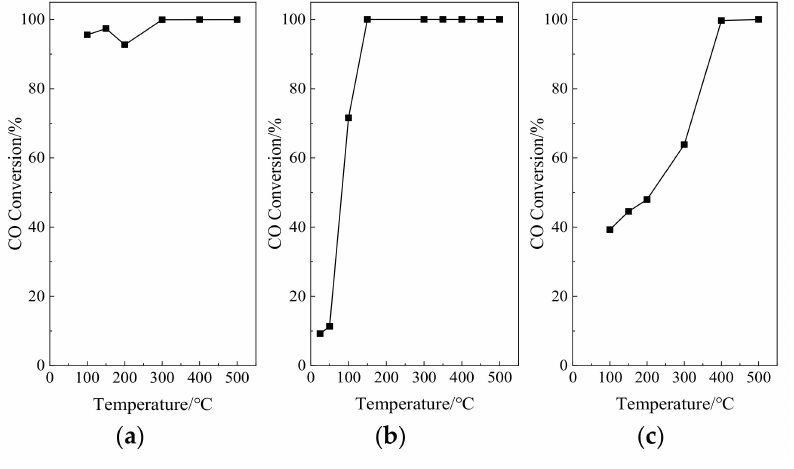
Figure 9. CO conversion vs. temperature: ( a ) Fe 0.8 Cu 0.2 /RHA; ( b ) Fe 0.67 Cu 0.33 /RHA; ( c ) Fe 0.5 Cu 0.5